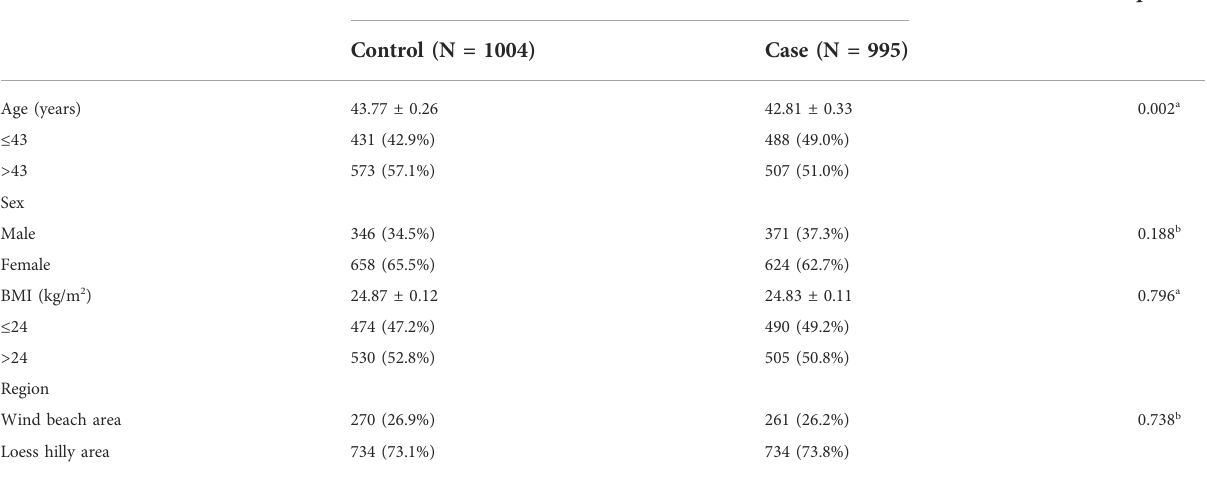
TABLE 1 Basic information of patients with AR and